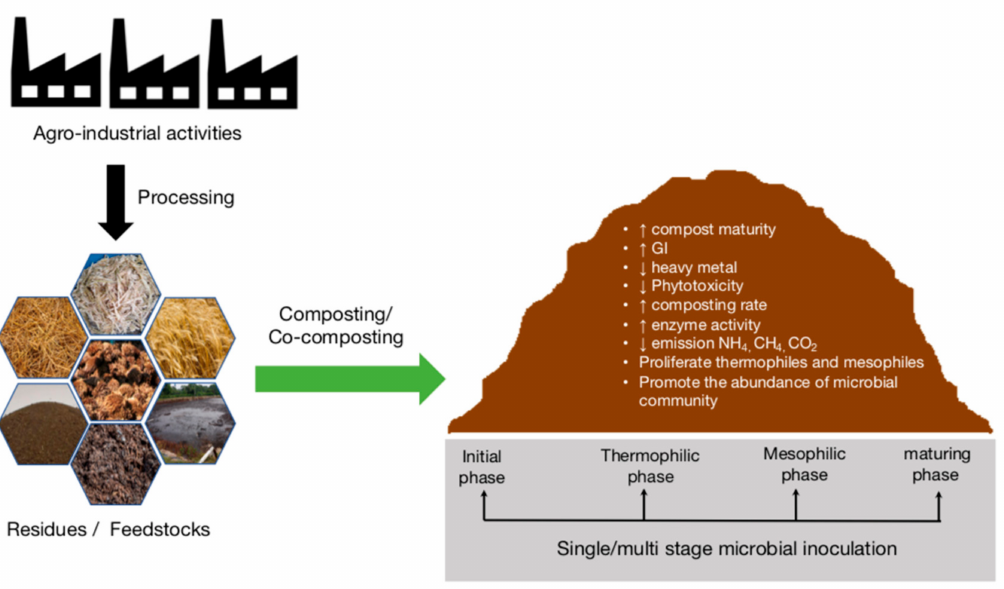
Figure 1. Overview of the composting process with the addition of inoculum. The microbial inoculum can be added either in a single stage, two-stages or multi- stages of the composting process, and a significant impact on physicochemical param- eters can be seen when the inoculum was added at different stages of the composting process [51,52]. For example, a study by Zeng et al. [53] indicated that the addition of Phanerochaete chrysosporium during the second phase promotes a significant change in com- post maturity as compared to the inoculation during the first phase of agricultural waste (rice straw + bran + vegetable) composting process. The bacterial inoculation at differ- ent stages of rice straw [54], maize straw [55] and peel citrus [9] composting showed a significant enhancement of lignocellulose degradation, thus, reducing the C/N ratio and composting period. A review by Fan et al. [7] reported that the microbial inoculation